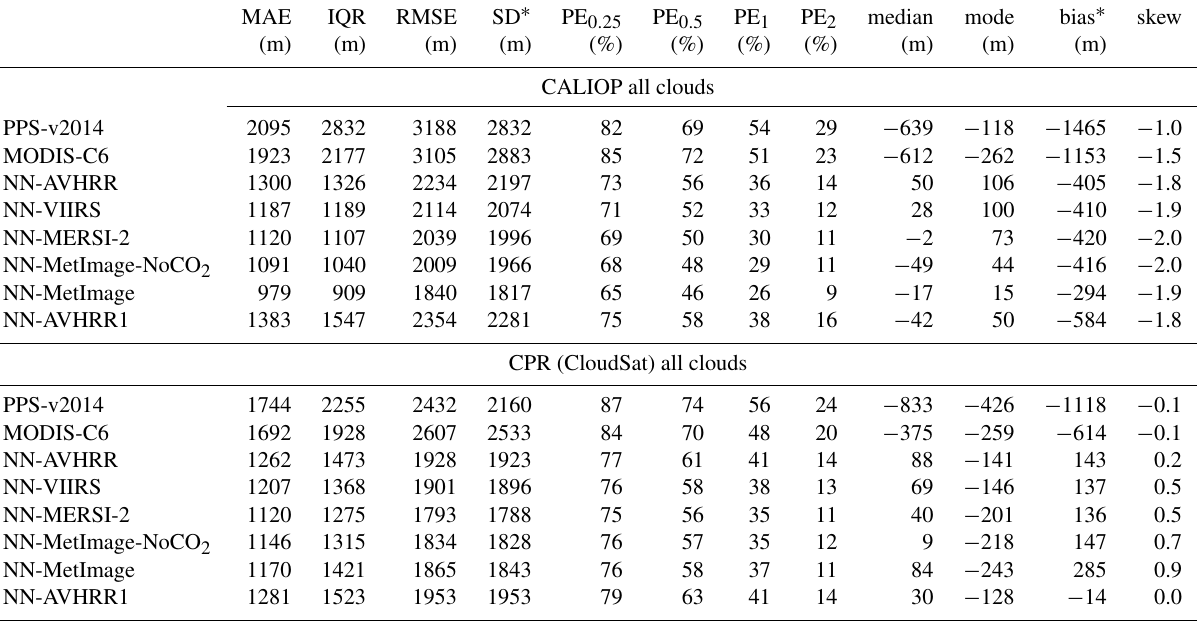
Table 6. Statistic measures for the error distributions for all clouds. For all measures except skewness it is the case that values closer to zero are better. The statistics are calculated for 1198599 matches for CPR (CloudSat) and 1803335 matches for CALIOP. A small amount 0.2% of the matches were excluded because of missing height or pressure below 70hPa for any of the algorithms. PE X describes percentage of absolute errors above X km, see Eq.